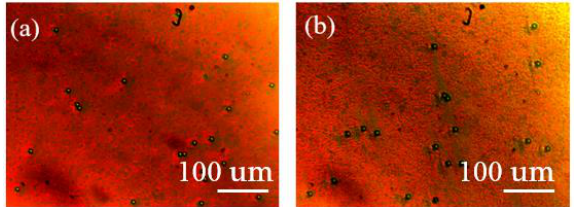
Figure 6. The surface morphology of ( a ) PS-BPLC and ( b ) T-BPLC.